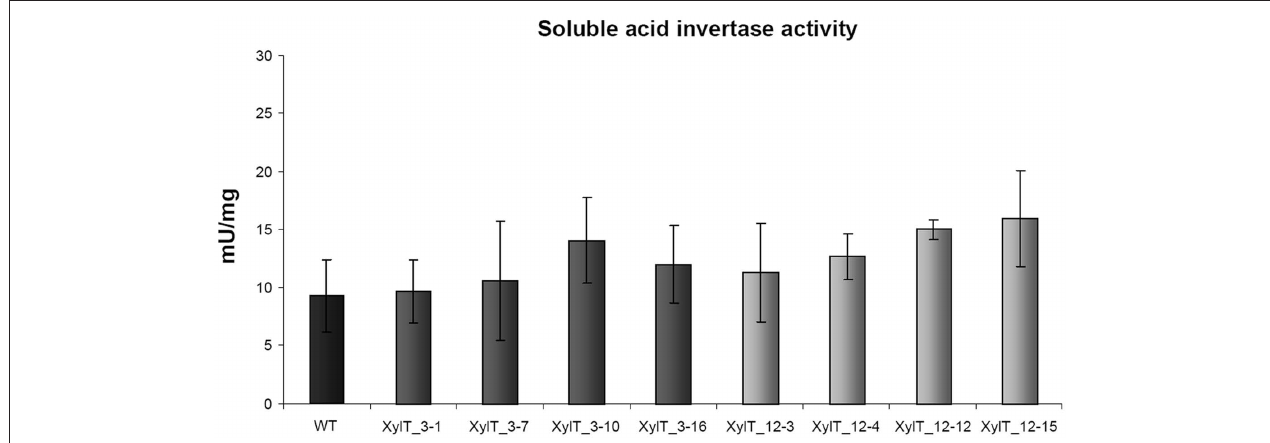
FiguRe 9 | invertase enzyme activity measurements. Soluble invertase activity in protein extracts from leaves of L. esculentum cv. MicroTom wild type (WT) and independent T1-plants of transgenic XylT_RNAi line 3